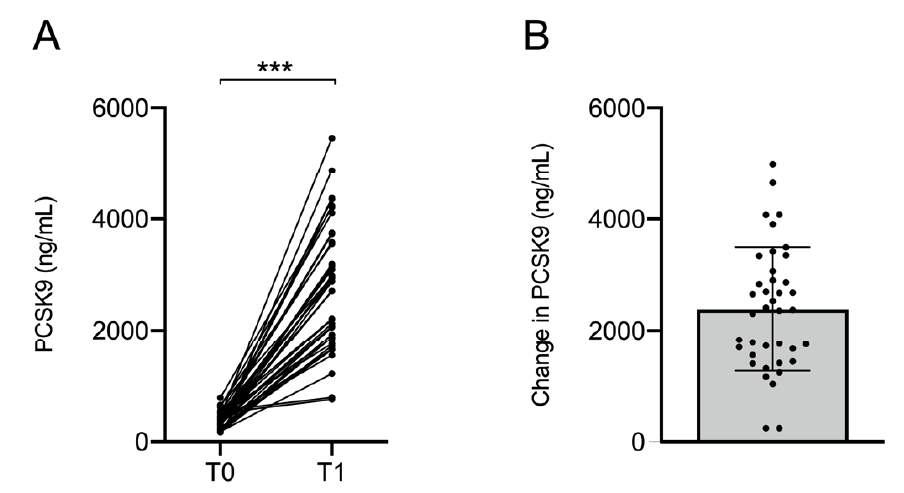
Figure 3. Circulating PCSK9 concentrations before and after PCSK9 inhibition therapy. ( A ) Individual patient data and ( B ) mean change in PCSK9 concentration. Error bars indicate SD. *** p < 0.001. The increase in circulating PCSK9 levels showed a strong and inverse correlation with differences in total cholesterol (r = − 0.633, p < 0.001), LDL cholesterol (r = − 0.732, p < 0.001), apoB (r = − 0.654, p < 0.001), total LDL particles (r = − 0.531, p = 0.001) and all subtypes of LDL particles (large: r = − 0.513, p = 0.002; medium: r = − 0.540, p = 0.001; and small: r = − 0.439, p = 0.011) and an inverse association with changes in apoA-I levels (r = 0.374, p = 0.032). No significant correlations were found between the increase in PCSK9 concentrations and changes in GlycA (r = − 0.193, p = 0.282), GlycB (r = 0.184, p = 0.305) or GlycF (r = − 0.087, p =